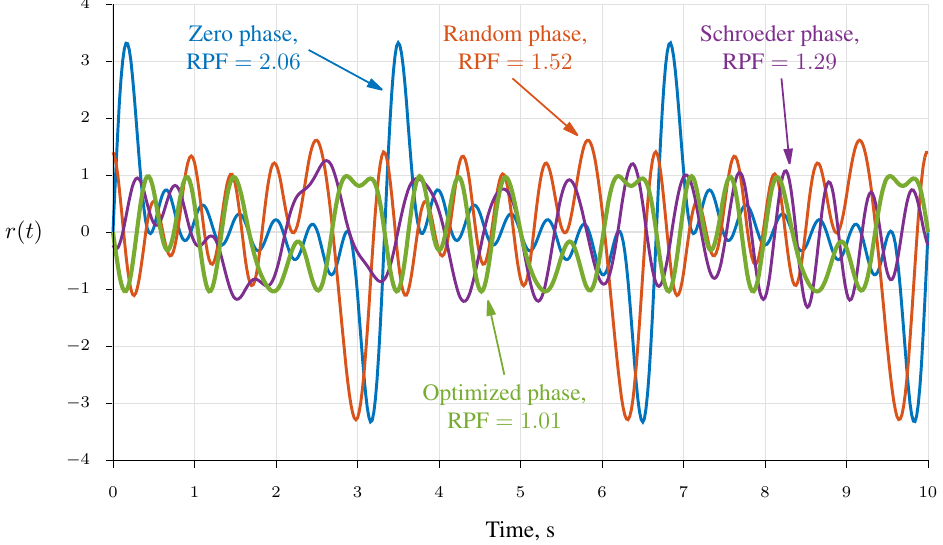
Figure 3. The effect of phase angles on a